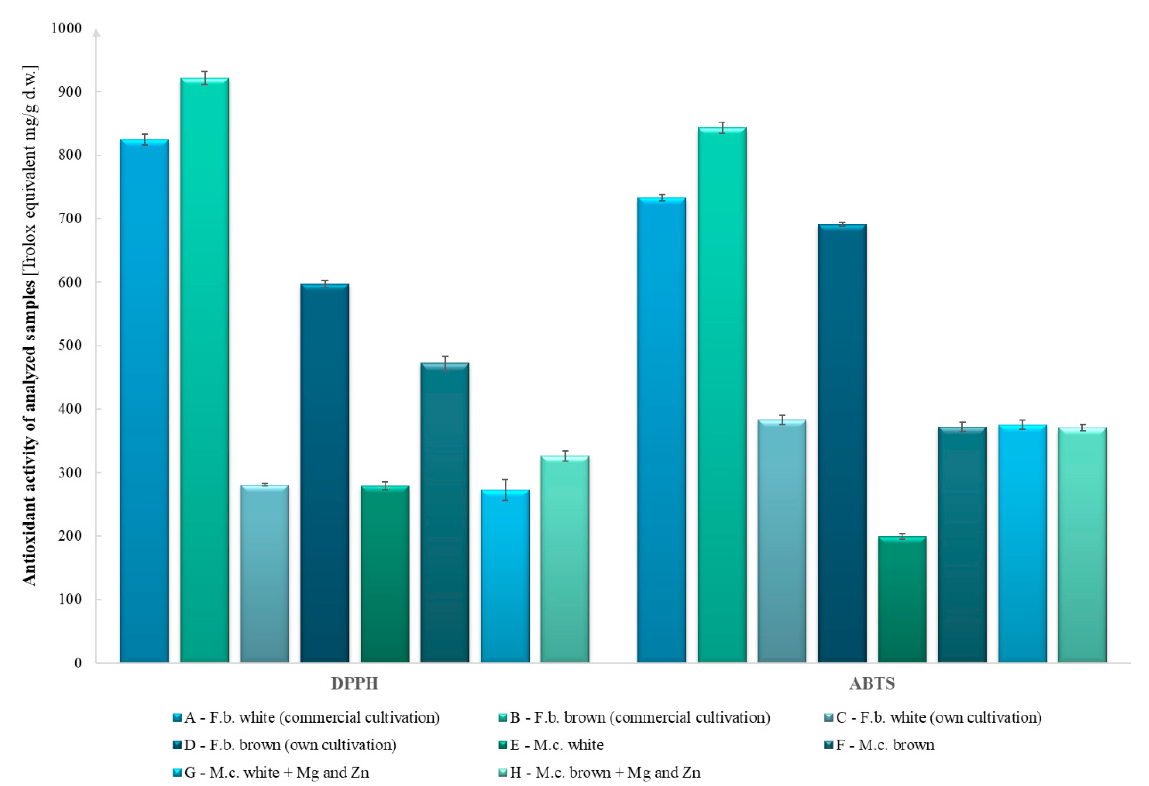
Figure 1. Comparison of antioxidant activity by DPPH and ABTS methods.